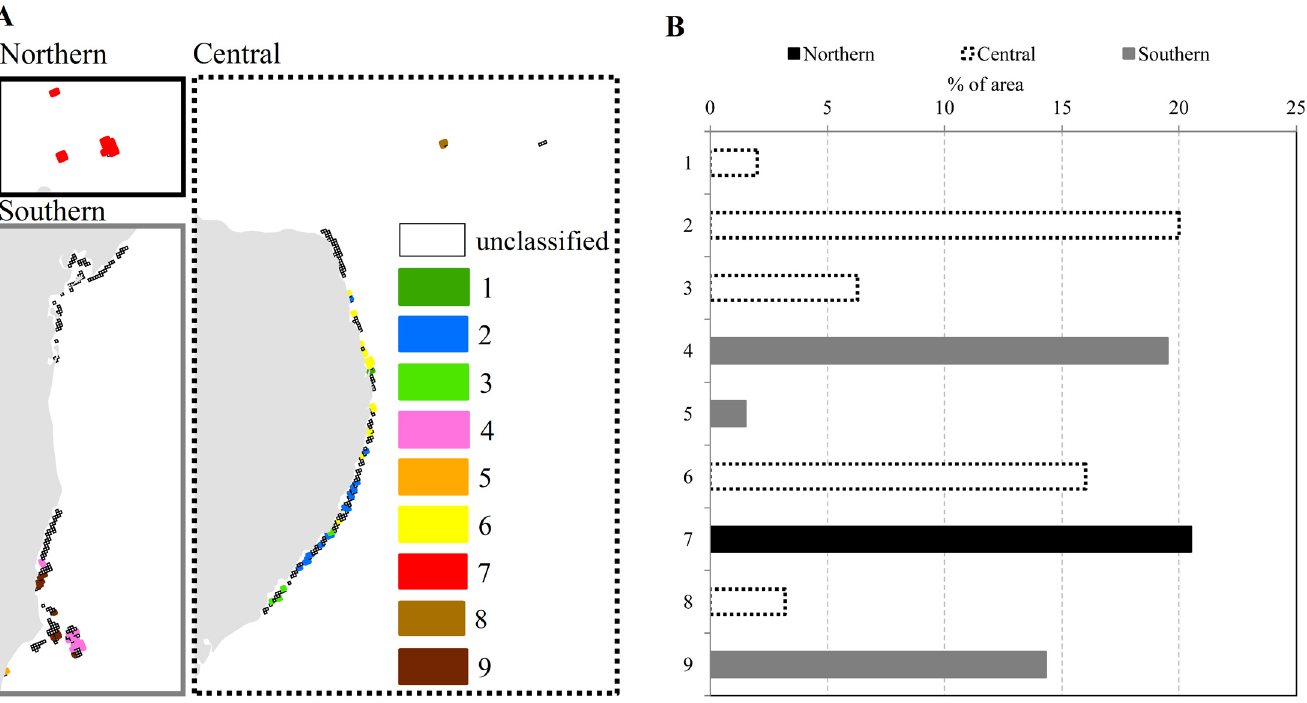
Fig 8. Distribution of thermal-stress regimes across study area. (A) Reef cells to which the nine regimes were allocated. Empty (black outlined) cells are unclassified because they have middle-tercile values for at least one of the four variables used to classify regimes. Labels for thermal regimes match those in Fig 4. Views for reefs in the northern, central, and southern sectors correspond to insets in Fig 2A. (B) Areal coverage of each thermal-stress regime as a percentage of the total of all reef cells allocated to regimes (n = 101). Each regime was encapsulated within a single sector.